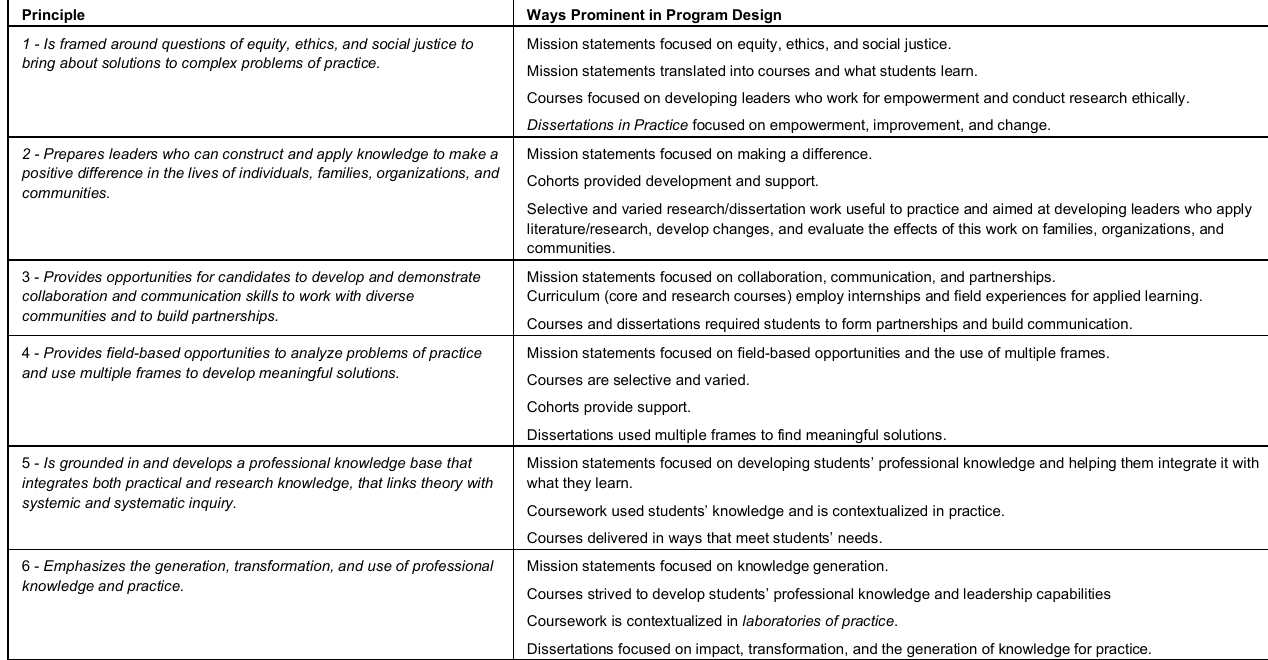
Table 1. The Guiding Principles implemented in EdD Program Design